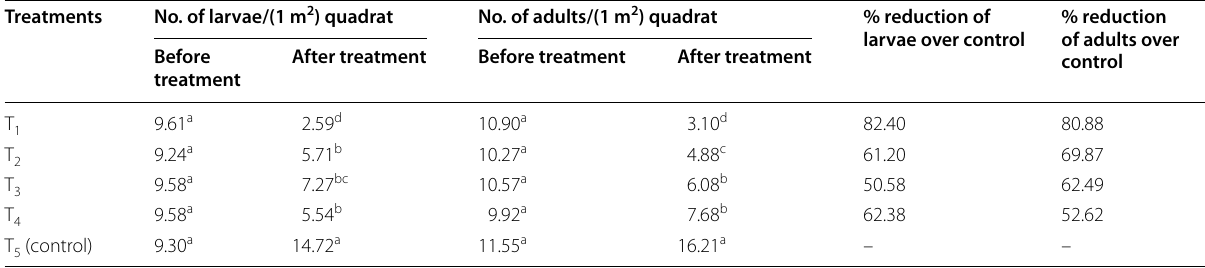
Table 6 Efficacy of different pest management modules in controlling hog-plum beetle, Podontia 14-punctata under field conditions during